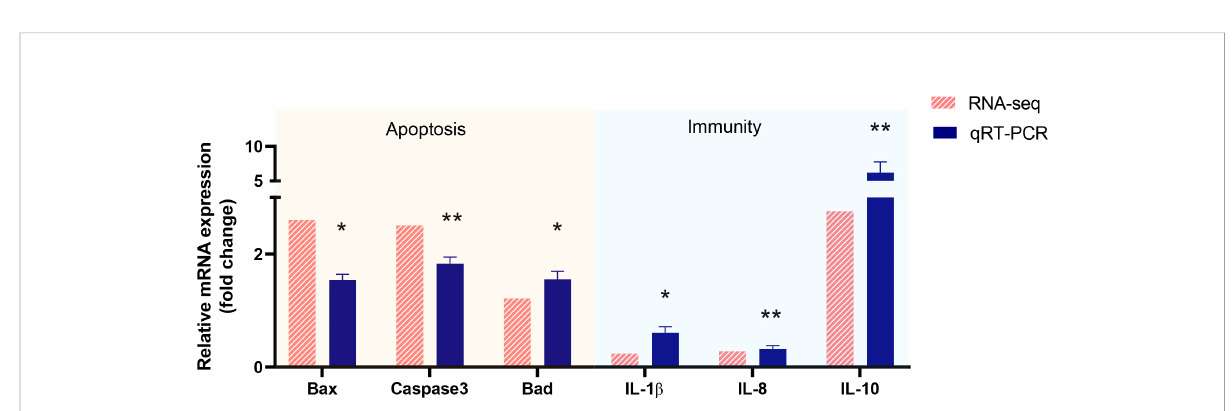
FIGURE 7 Validation of RNA-seq data by using real-time qRT-PCR. P < 0.05 (*), P < 0.01 (**), P < 0.001 (***).